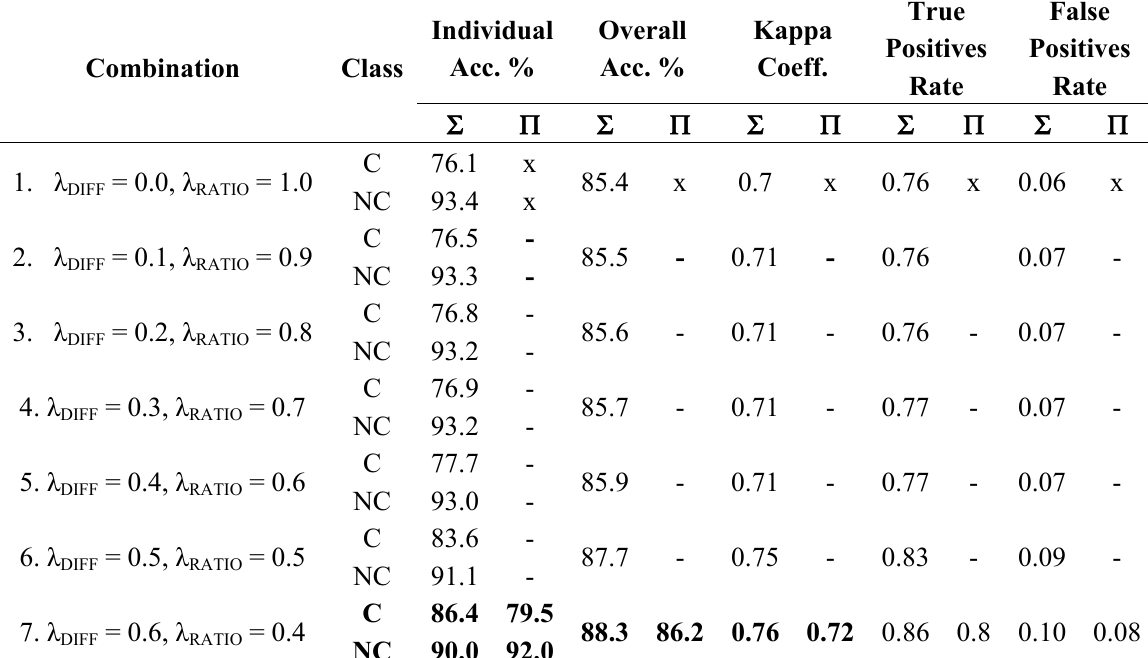
Table 5. Level 2. Individual and overall accuracies obtained for the multisource process as a function of the weights assigned to each index (Diff. & Ratio). Additive method ( Σ ), Multiplicative method ( Π